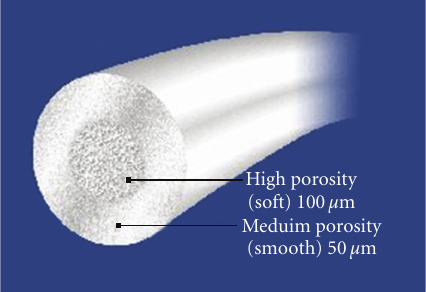
Figure 4: Advanta facial implants